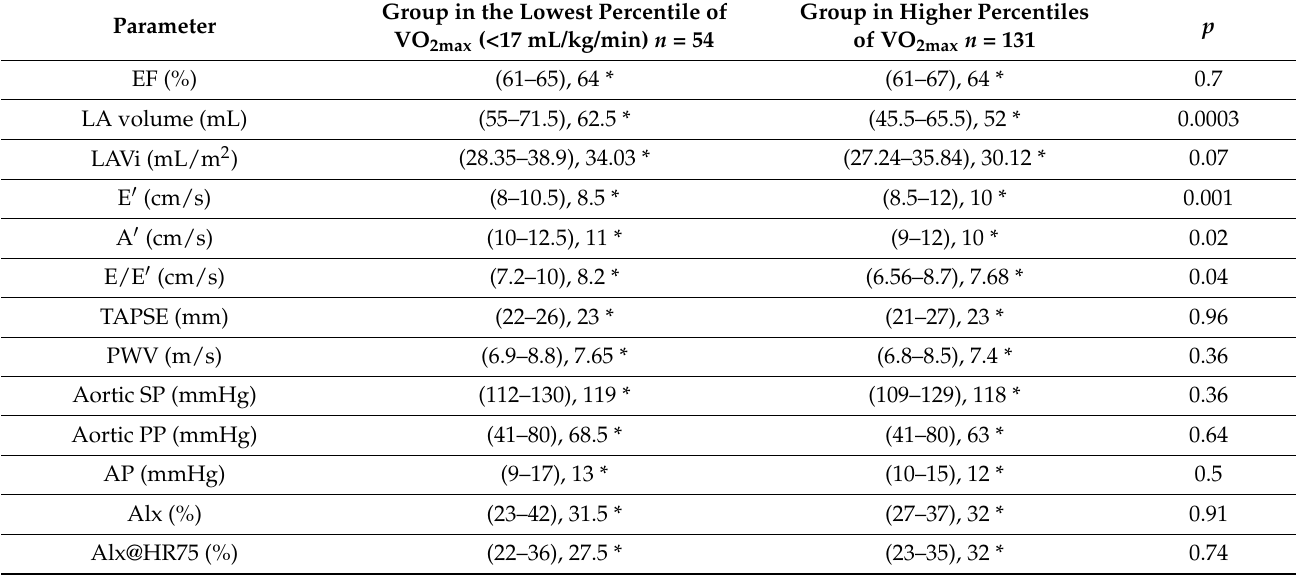
Table 2. Evaluation of selected echocardiographic and hemodynamic parameters among the groups.